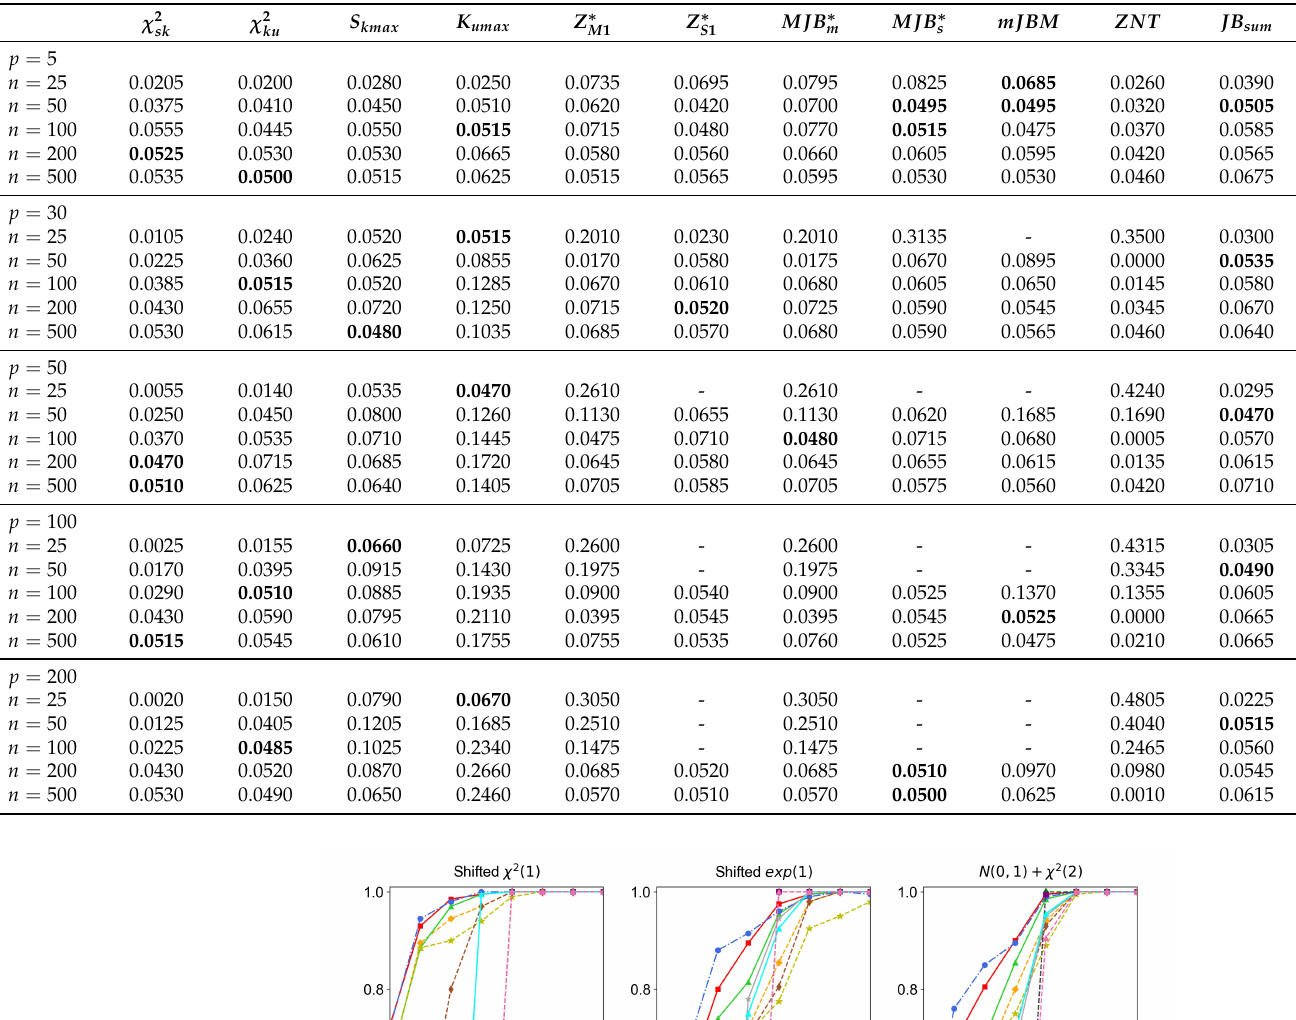
Table 5. Empirical power of PC-type Jarque–Bera (JB) testing for normally distributed data for Case-II compared with other methods ( α = 0.05).